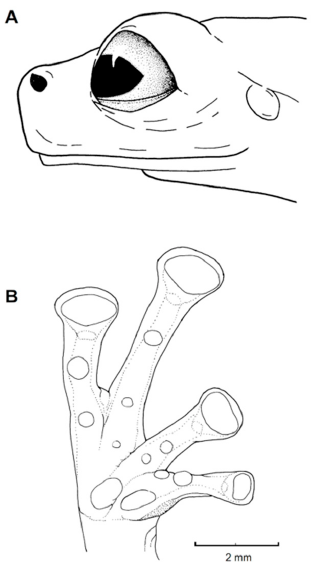
Figure 181. Nymphargus siren , KU 146610. ( A ) Head in lateral view. ( B ) Hand in ventral view. Illustrations by Juan M. Guayasamin. Color in life (Figure 180): Green dorsum with small yellow spots, which are narrowly bordered by black in some individuals [22]. Anterior half of venter white, posterior half transparent. Bones green. Iris whitish cream, with yellow hue around pupil and fine, dark grey reticulations. Color in ethanol: Dorsal surfaces of head, body, and limbs light to dark lavender with small white spots. Anterior half of ventral parietal peritoneum white; posterior half translucent. Translucent peritonea covering gall and urinary bladders. Iridophores absent from digestive tract, liver, and kidneys.